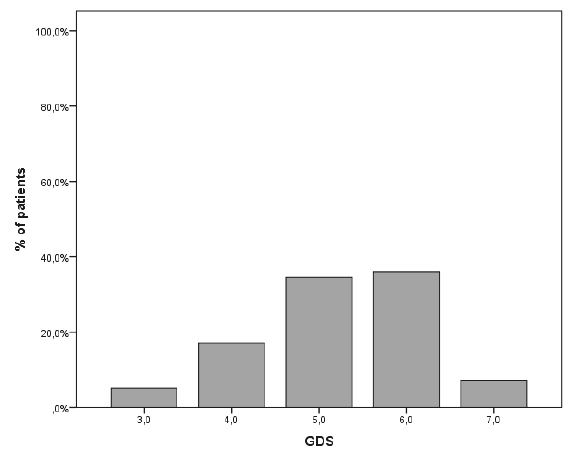
Figure 2: Distribution of GDS in the total sample of dementia patients based on their caregivers’